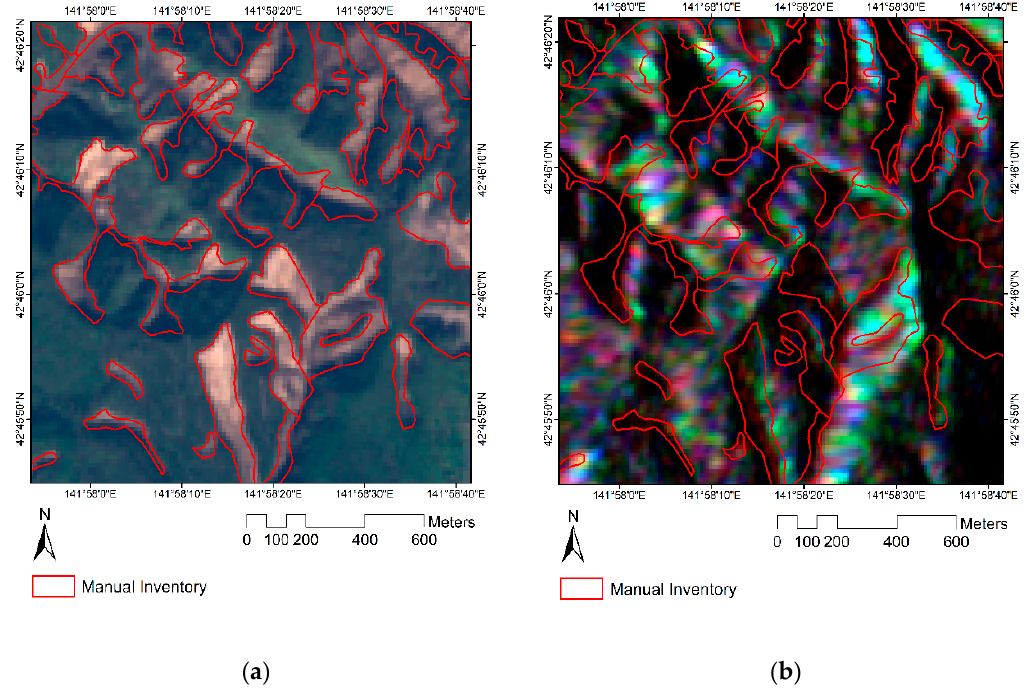
Figure 3. Manual landslide inventory visualized on ( a ) Sentinel-2 optical image and ( b ) D_BAA_S composite image.